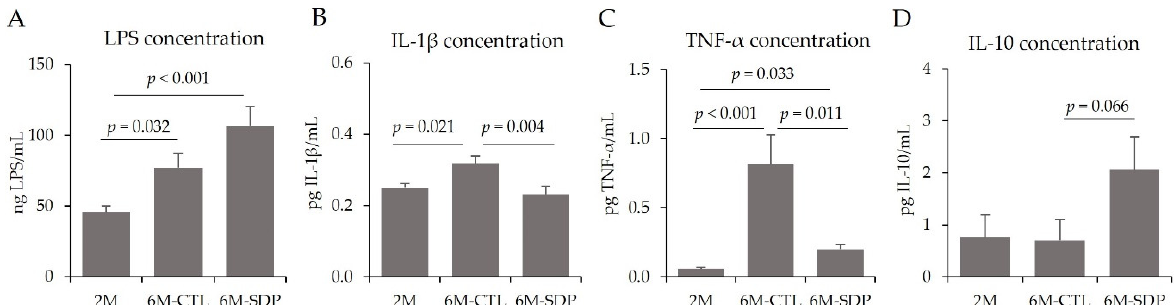
Figure 7. Systemic inflammation. Concentrations of LPS ( A ), IL-1 β ( B ), TNF- α ( C ), and IL-10 ( D ). Results are expressed as mean ± SEM ( n = 8–9 mice/group). Statistics: ANOVA (Fisher multiple comparison test). IL, interleukin; LPS, lipopolysaccharide; TNF- α , tumor necrosis factor-alpha.